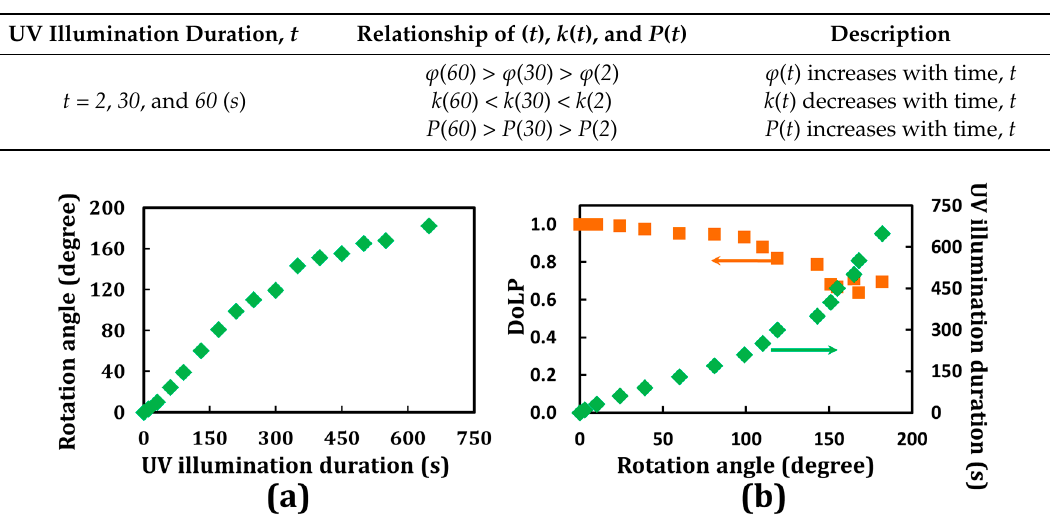
Table 2. Relationship of ϕ ( t ), k ( t ), and P ( t ) as t = 2, 30, and 60 s.